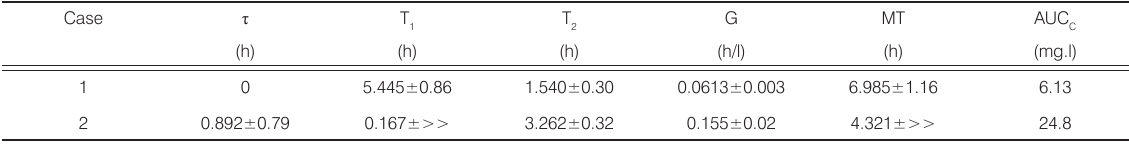
Table 2. The estimated model parameters of PK system in two cases of combined administration of atenolol and valsartan single doses.